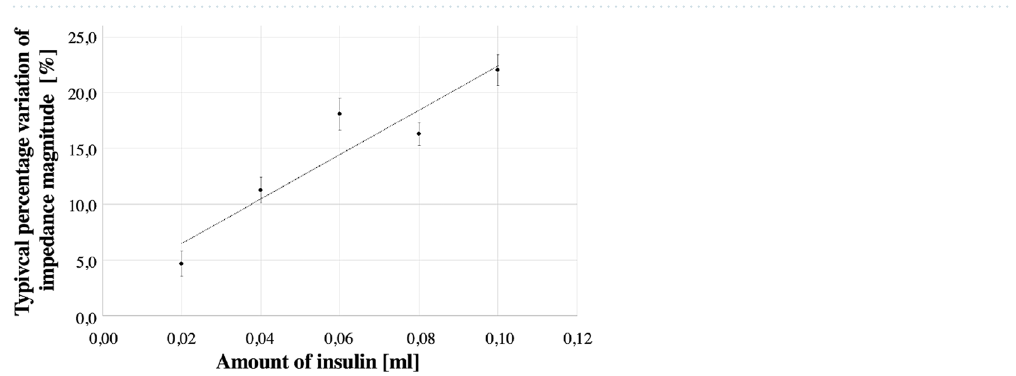
Figure 7. Percentage accuracy of personalized (+) and generic ( × ) model versus amount of insulin, in in-vitro experiments for ( A ) 12-mm and ( B ) 5-mm setup.